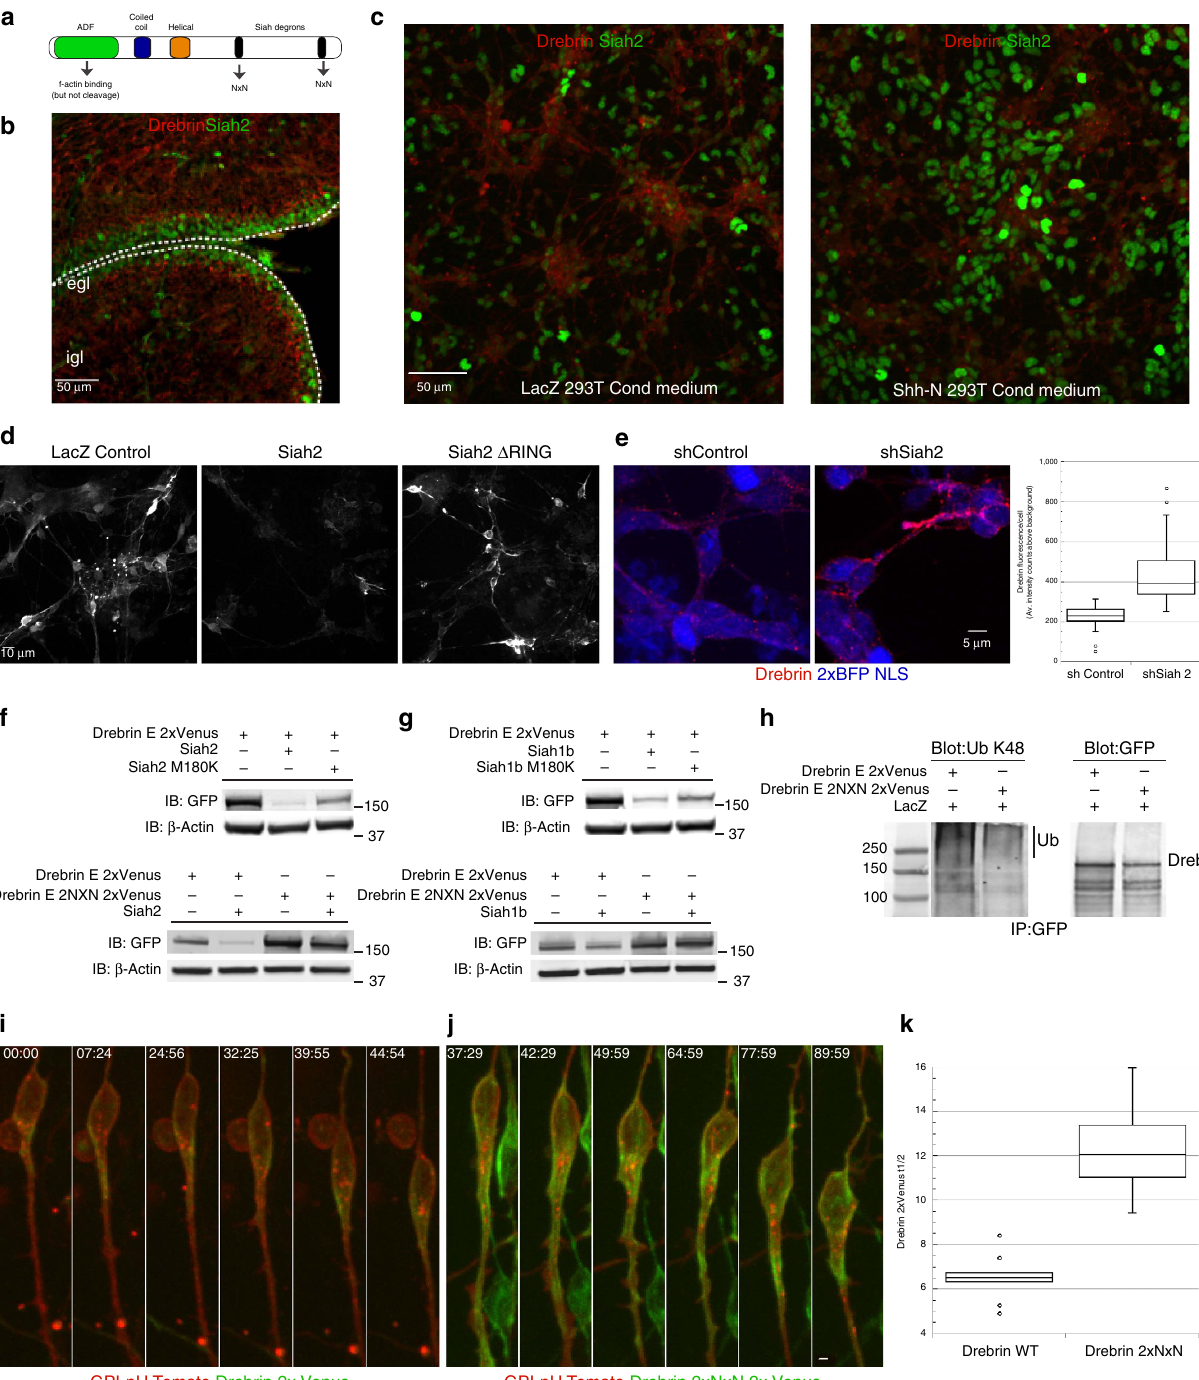
Drebrin E 2xVenus Drebrin E 2NXN 2xVenus